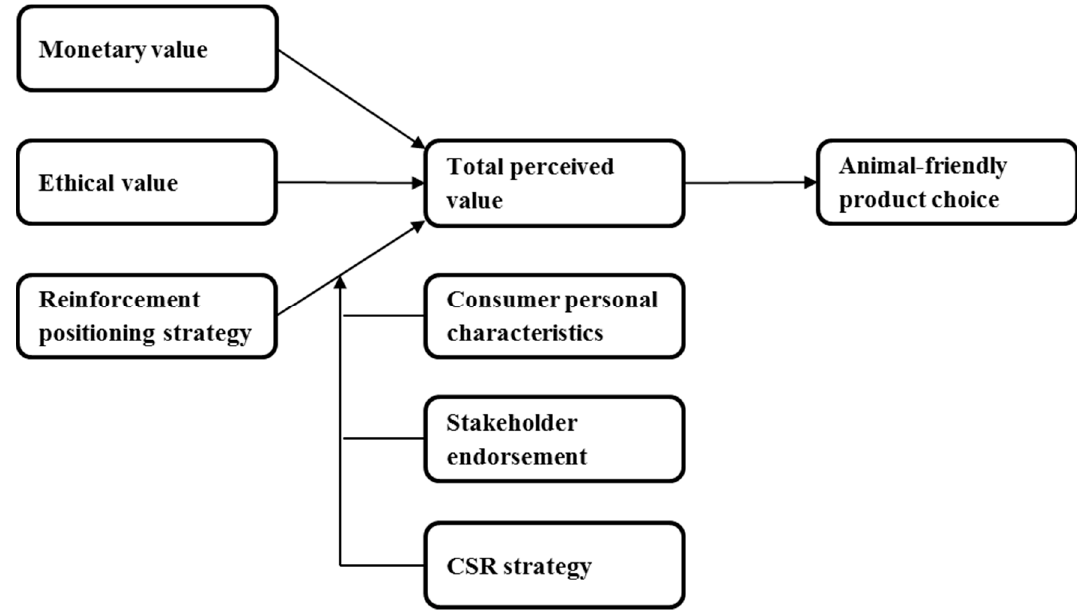
Figure 1. Conceptual framework.